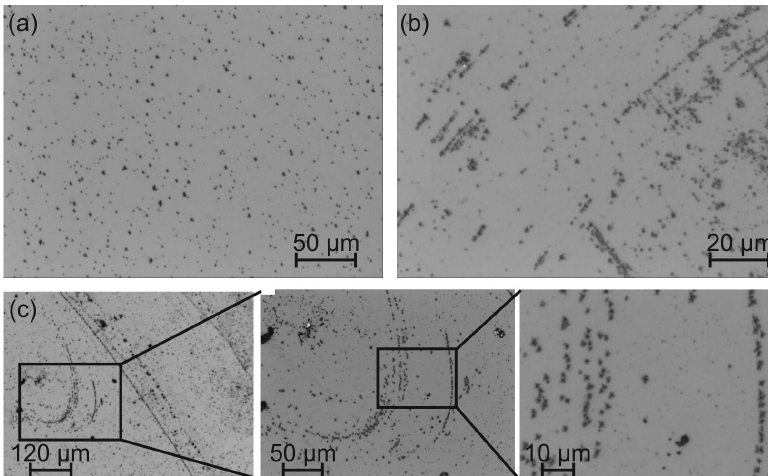
Figure 1. Light microscope image of the 48 h preheated La 3 Ga 5 SiO 14 (LGS) substrate showing ( a ) a region with homogeneous distribution; and ( b ) the agglomeration of the features along scratches at the sample surface; ( c ) Overview image the 10 + 48 h LGS substrate together with zoom images showing agglomeration of the features at